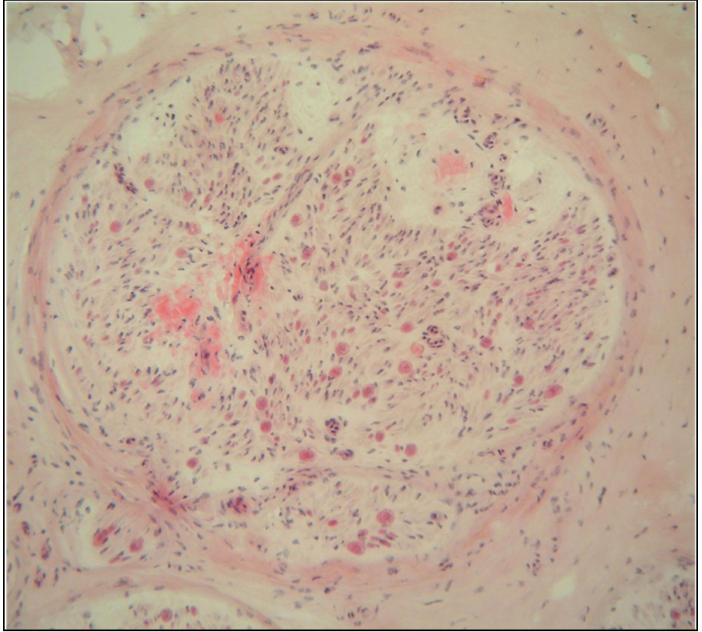
Figure 4. Sural nerve biopsy from a late onset ATTRv patient. H&E showing abundant eosinophilic deposits suggestive of